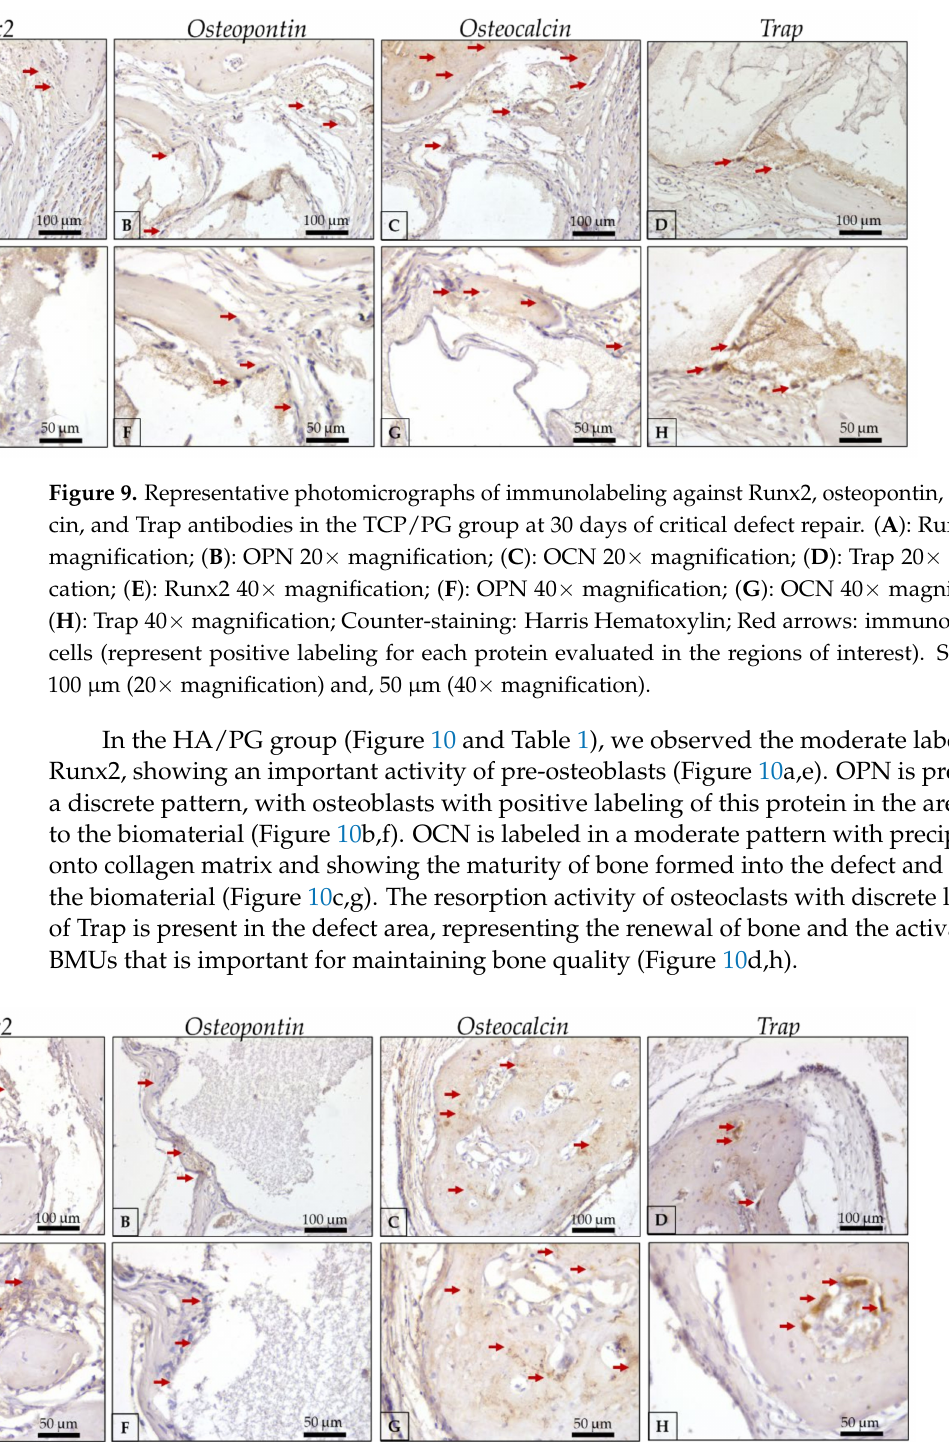
Figure 10. Representative photomicrographs of immunolabeling against Runx2, osteopontin, osteo- calcin, and Trap antibodies in the HA/PG group at 30 days of critical defect repair. ( A ): Runx2 20 × magnification; ( B ): OPN 20 × magnification; ( C ): OCN 20 × magnification; ( D ): Trap 20 × magnifi- cation; ( E ): Runx2 40 × magnification; ( F ): OPN 40 × magnification; ( G ): OCN 40 × magnification; ( H ): Trap 40 × magnification; Counter-staining: Harris Hematoxylin; Red arrows: immunolabeling cells (represent positive labeling for each protein evaluated in the regions of interest). Scale bar: 100 µ m (20 × magnification) and, 50 µ m (40 ×